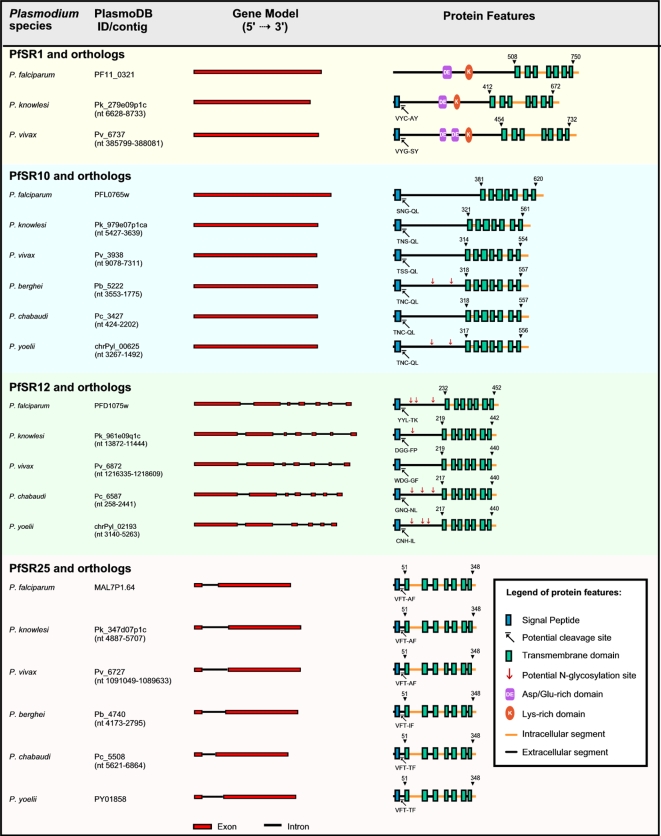
Characteristics of serpentine receptor-like proteins (SRs) of diverse malaria parasites species.Each one of the four P. falciparum serpentine receptors sequences are grouped with its orthologs and differently colored: yellow, PF11_0321 (PfSR1); blue, PFL0765w (PfSR10); green, PFD1075w (PfSR12); pink, MAL7P1.64 (PfSR25). Identification numbers for most of the non-falciparum sequences are not available since these genes are not annotated in the databases; therefore, we point out the contig sequences from where they were retrieved with the nucleotides that comprise the selected gene. Scale-sized diagrams of genomic structure of serpentine receptor genes (Gene Model) and of predicted protein features are shown. Transmembrane domains predicted by TMHMM2.0 are shown in dark-green boxes, with the number of amino acids in the beginning and in the end of the 7-TM core. Potential signal peptides predicted by SignalP3.0 are shown as blue boxes with the potential cleavage sites. In the N-terminal domains of some of these receptors there are repetitive stretches of negatively charged residues (Glu/Asp-rich domains) or positively charged residues (Lys-rich domains). The position of potential N-glycosylation sites is pointed by red-arrows.